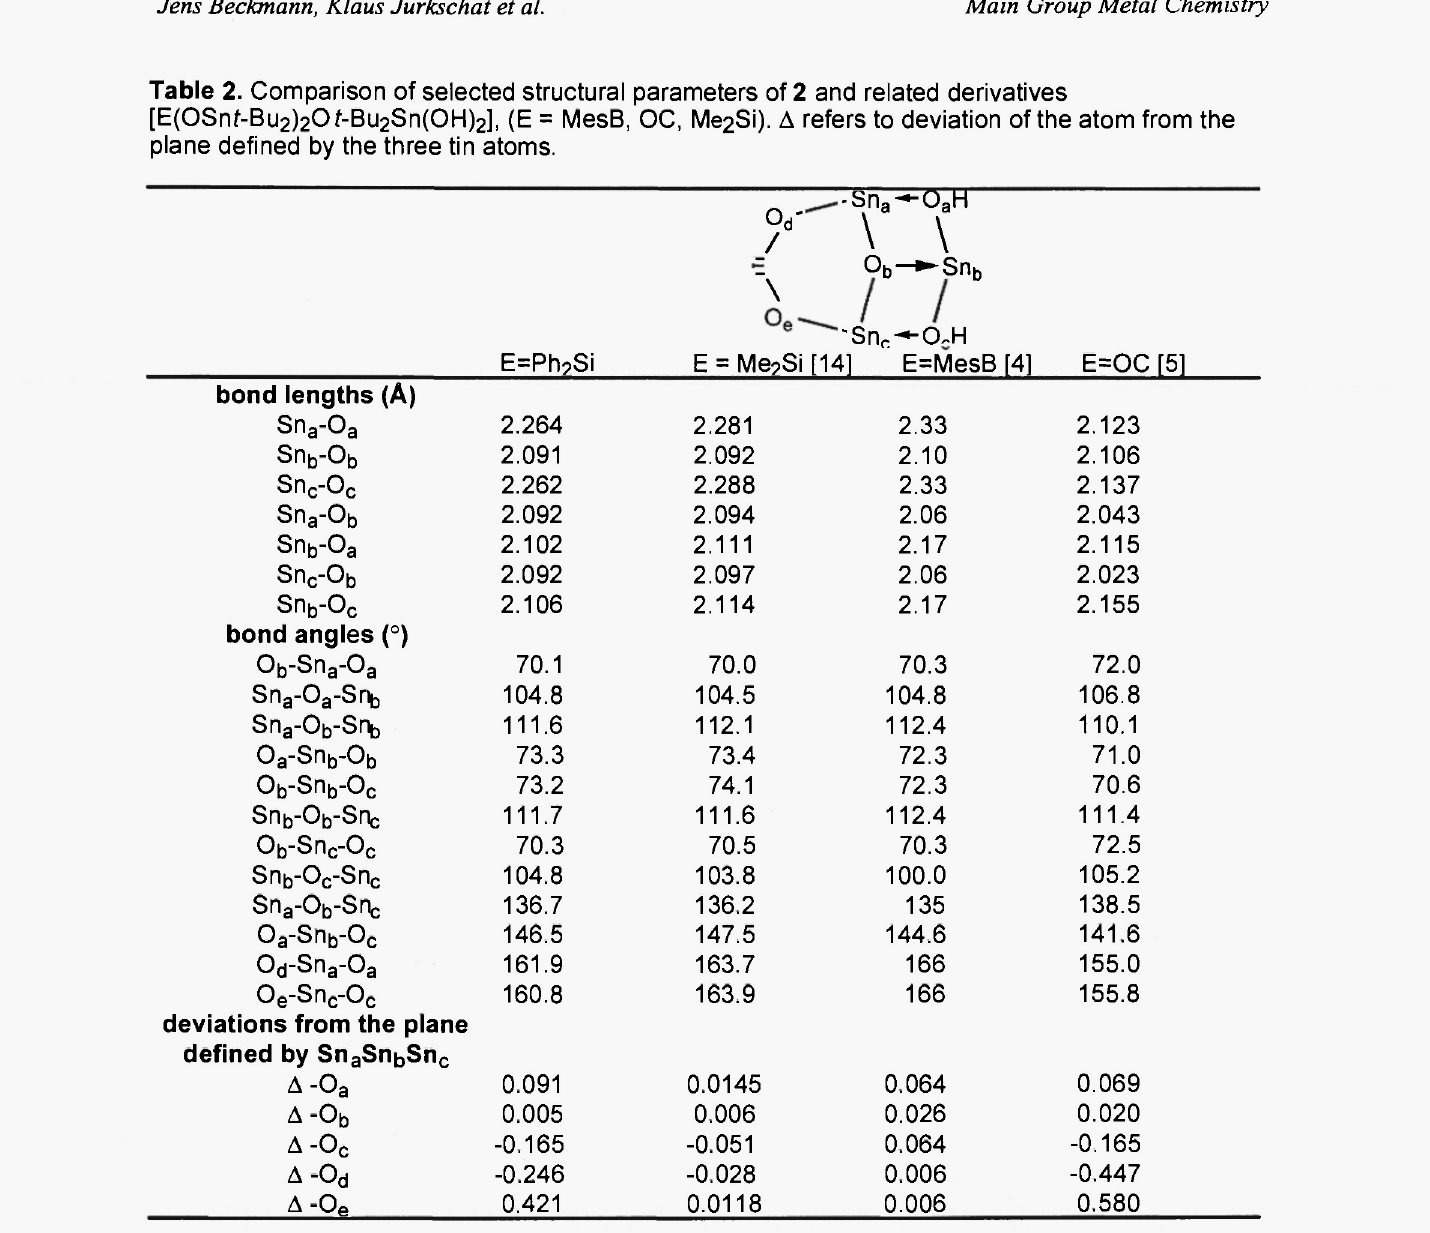
Table 2. Comparison of selected structural parameters of 2 and related derivatives [E(OSnf-Bu ) Of-Bu Sn(OH) ], (E = MesB, OC, Me2Si). Δ refers to deviation of the atom from the 2 2 2 2 plane defined by the three tin